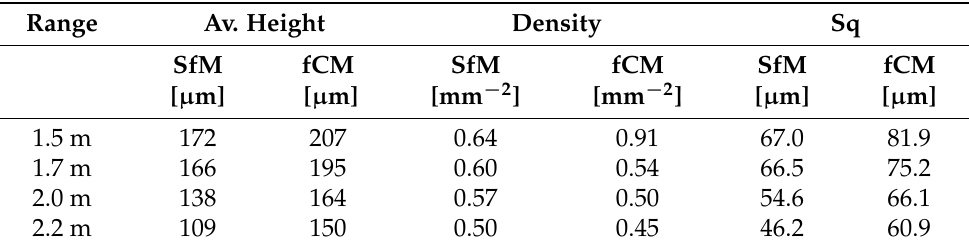
Table 6. Parameters of sandpaper P40 artifact from SfM measurements at a varying range and fCM data of a varying filter width. Values shown are the average particle height, particle area density as well as the S q roughness parameter.